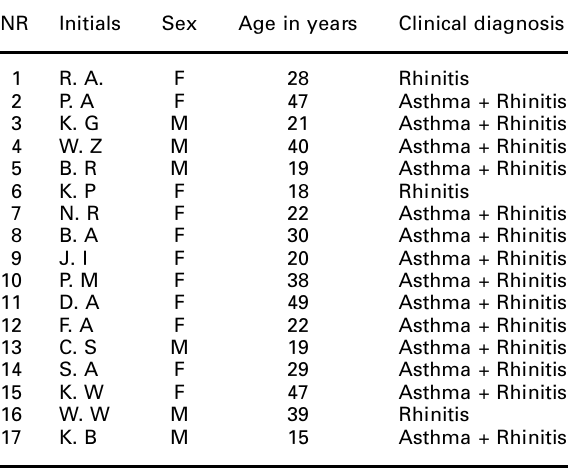
Table 1. Characteristics of allergic